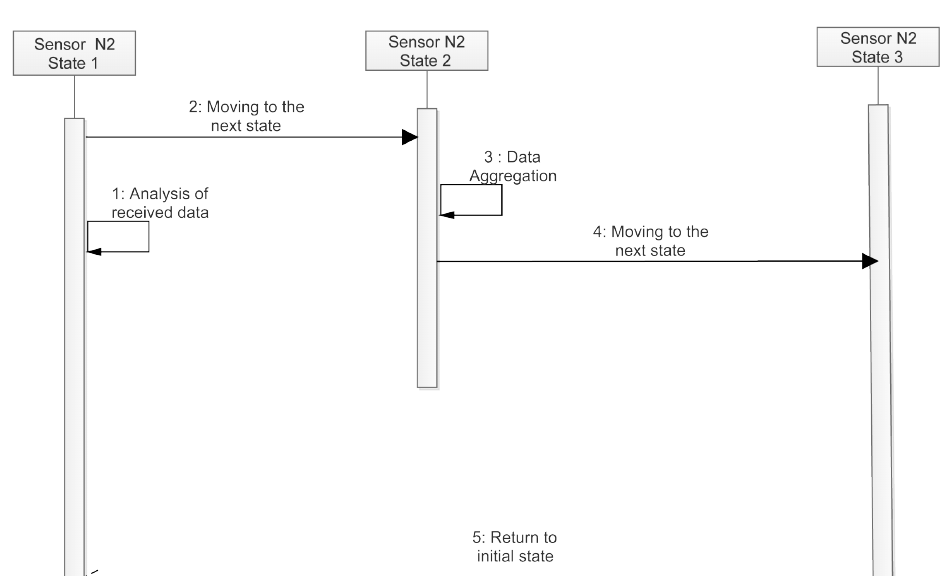
Figure 7. Diagram of activity sequences of second level architecture